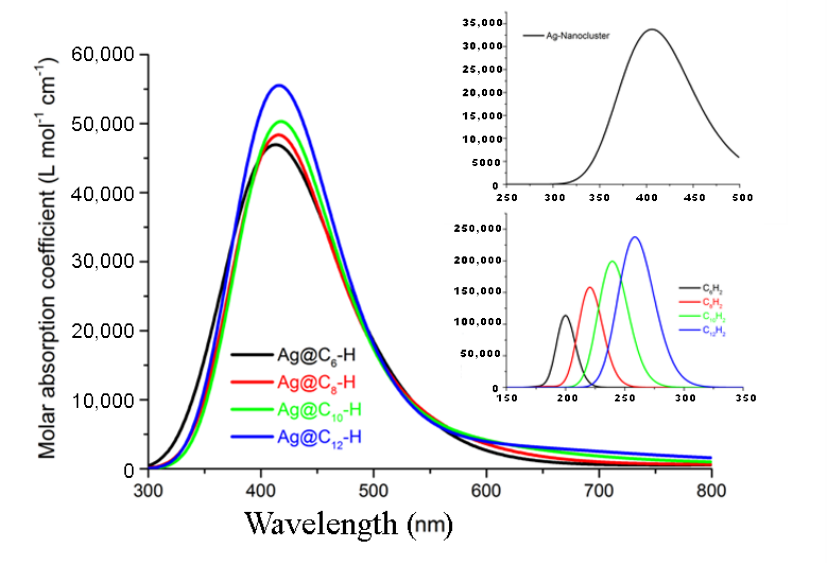
Figure 8. Absorption spectra of Ag@C 2 n –H, 3 ≤ n ≤ 6 at the MO62X/6-311+G(d,p)/LANL2DZ level. The spectra are Gaussian broadened with 0.3 eV (half-width at half-maximum). The maximum absorption wavelength was found at 409 nm for the shortest Ag@C 6 –H; a moderate red-shift was observed with the π -delocalization with a maximum absorption of 427 nm observed for Ag@C 12 –H. The typical Ag plasmonic profile for the simulated systems showed asymmetry at higher wavelengths than measured in the experiments, and its occurrence indicated an aggregation of smaller-sized